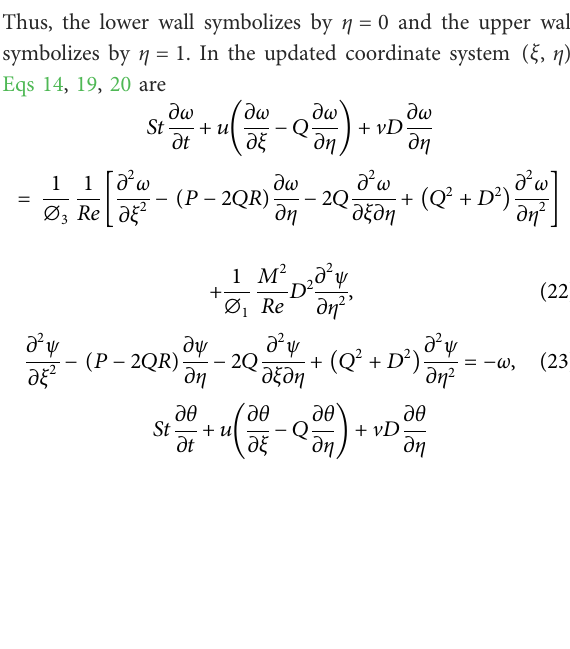
Frontiers in Energy